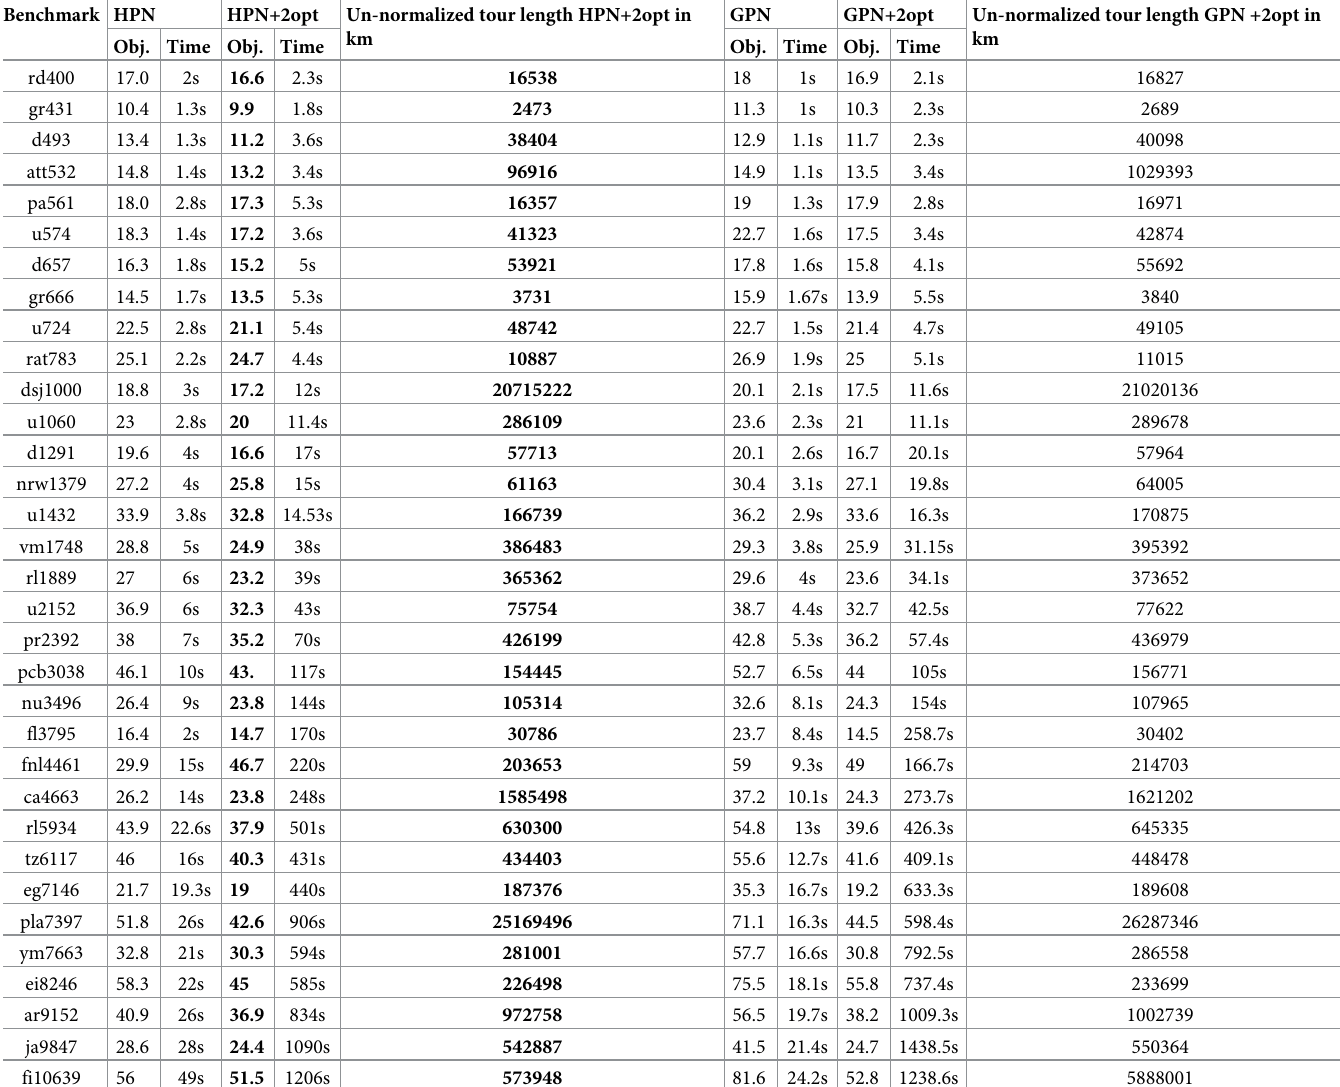
Table 3. Evaluation on real world TSPLIB dataset using HPN and HPN+2opt.